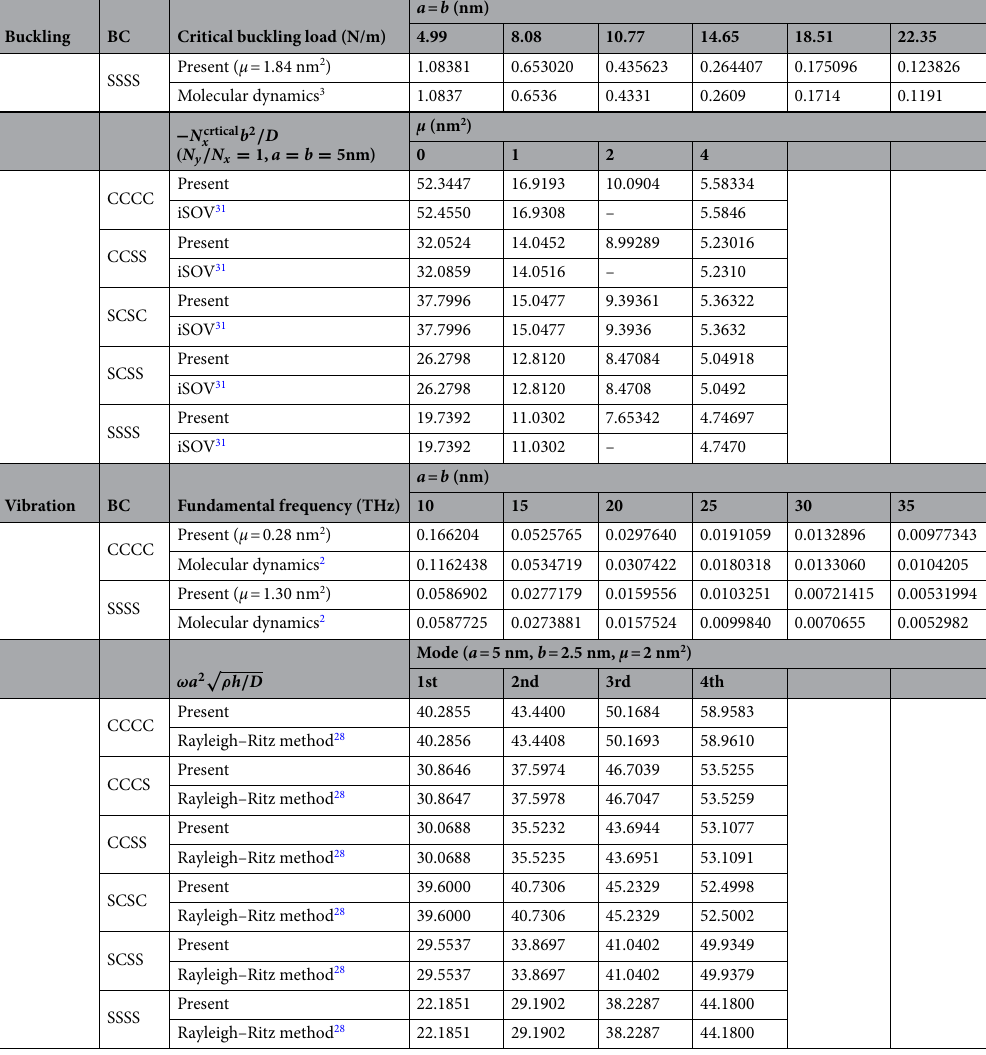
Table 2. Comprehensive comparison of the critical buckling load and fundamental frequency